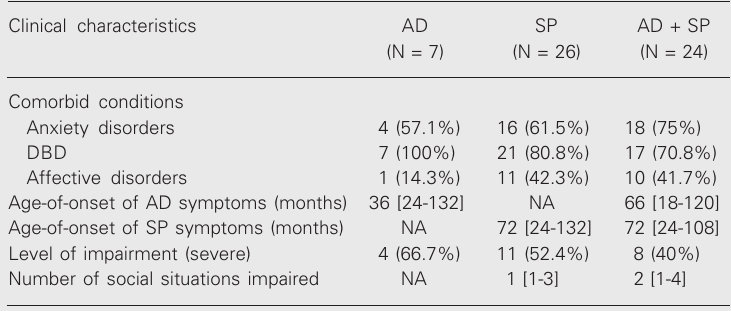
Table 1. Clinical characteristics of the child and adolescent groups studied. Clinical